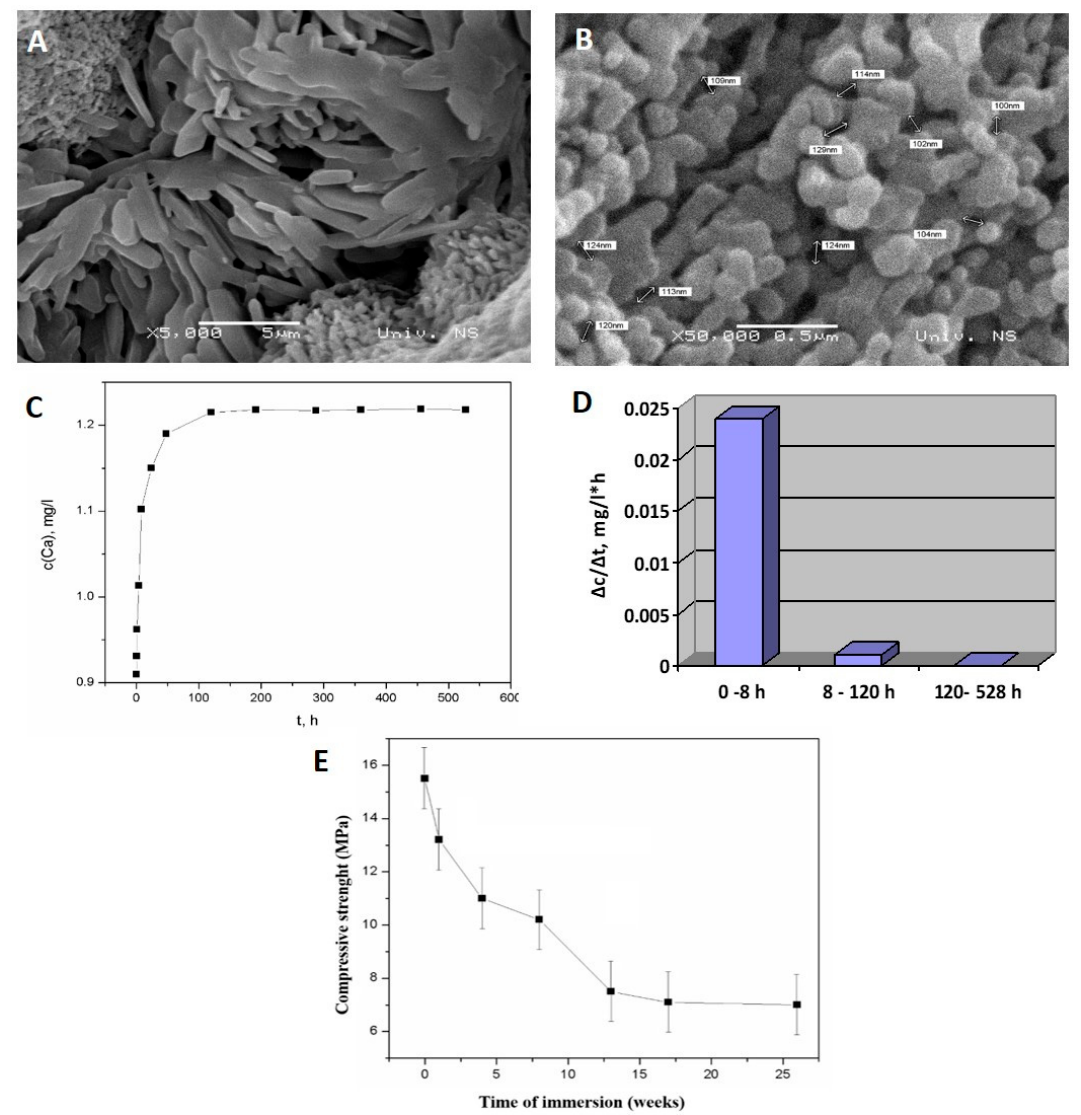
Figure A2. The SEM micrographs of nanoHAP-PLGA ( A ) 5000 × , ( B ) 50,000 × ; ( C ) Change of the Ca 2+ concentration in solution containing nanoHAP granules with time; ( D ) The rate of nanoHAP degradation during prolonged time period (0–428 h); and, ( E ) Change of compressive strength during nanoHAP degradation.